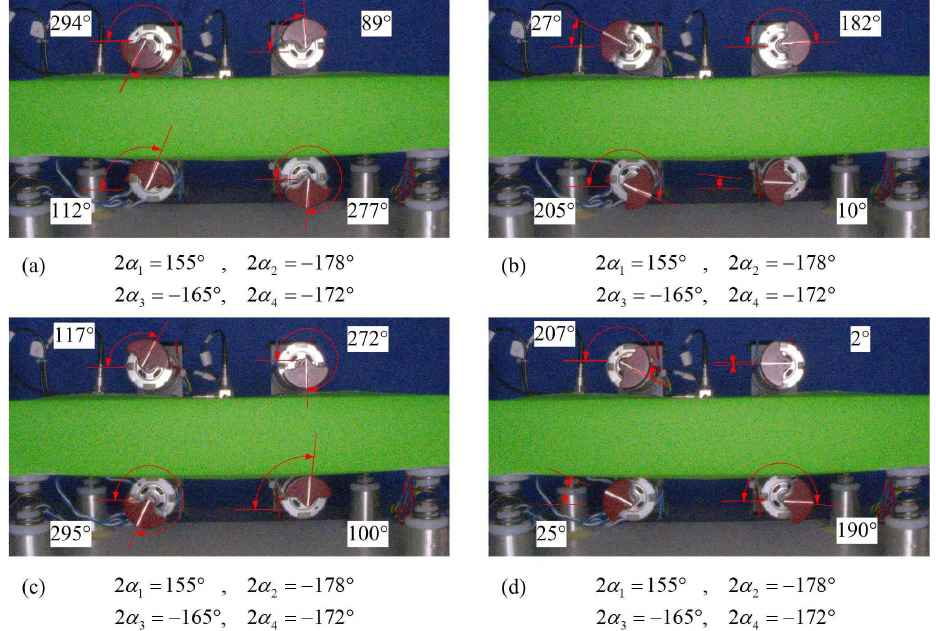
. These results are consistent with those in Figure 10b.